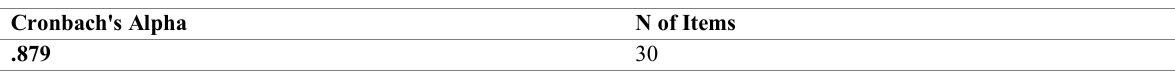
Table 4: Cronbach's Alpha